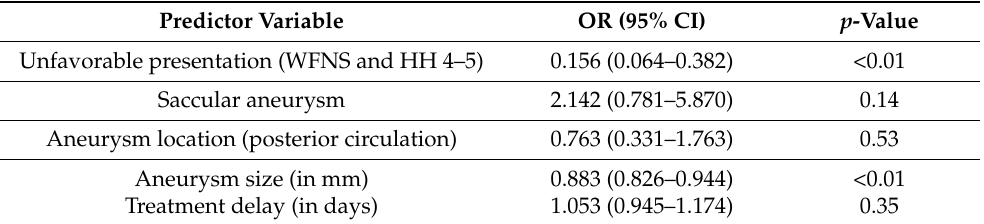
Figure 1. Meta-analysis of the favorable clinical outcome rate. Both the dichotomized treatment delay (within 72 h or ≥ 72 h) and treatment delay as continuous variables had no statistically significant correlation with the favorable outcome in the multiple logistic regression analysis (Table 2). Table 2. Logistic regression model for the favorable mRS after treatment with